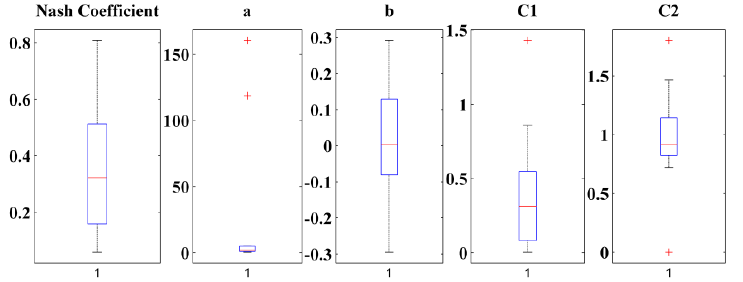
Figure 12. Boxplots of Nash–Sutcliffe coefficients, power build-up parameters and wash-off parameters obtained when calibrating over Periods of three continuous events.